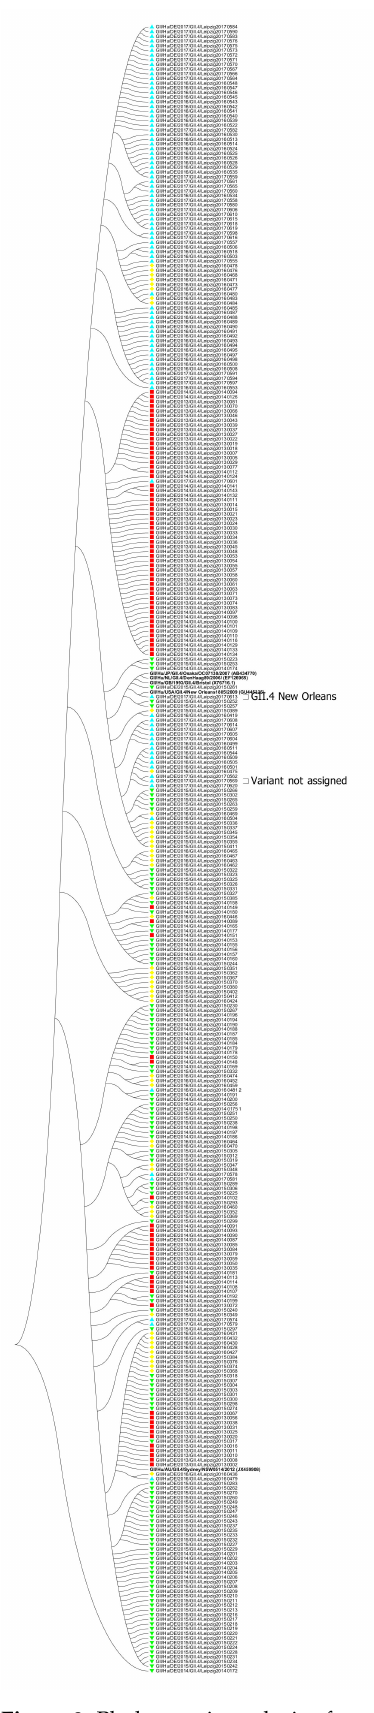
Figure 3. Phylogenetic analysis of norovirus GII.4 genotypes based on Maximum Likelihood